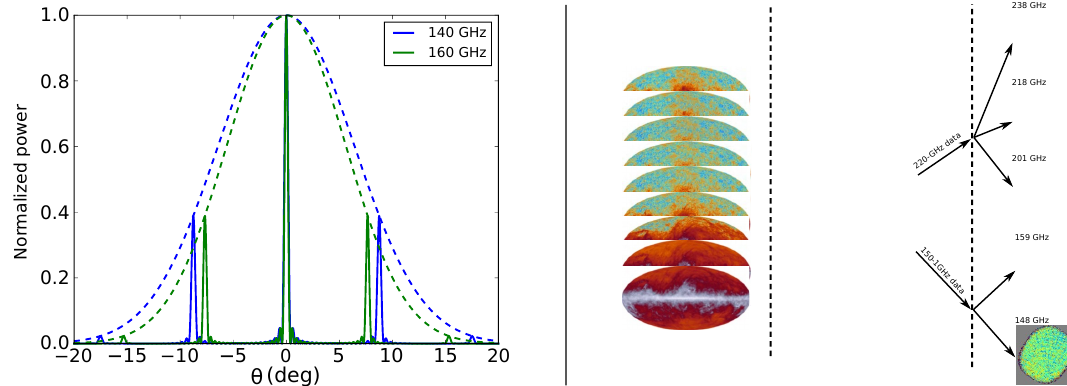
Figure 5. ( Left ) Cut of the synthesized beam for two monochromatic signals. The main central peaks superimpose each other, but the first lobes are separated so that they can be resolved. The dashed lines represent the horn beams. ( Right ) Schematics representing the ability to resolve spectral sub-bands in each of the main QUBIC bands. The instrument first separates the wide-band sky signal into two main bands (150 and 220GHz), then we further separate each band into sub-bands thanks to the spectral sensitivity of the synthesized beams. The Planck maps shown on the left have the only purpose of explaining the